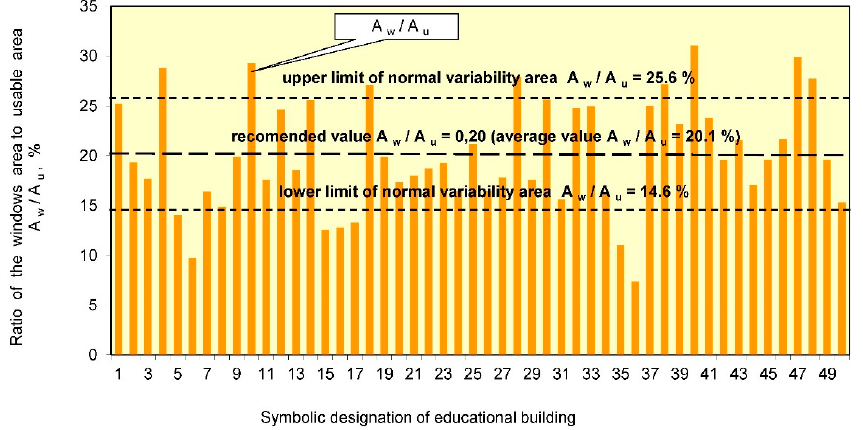
Figure 1. Values of the A w /A u indicator in education buildings.